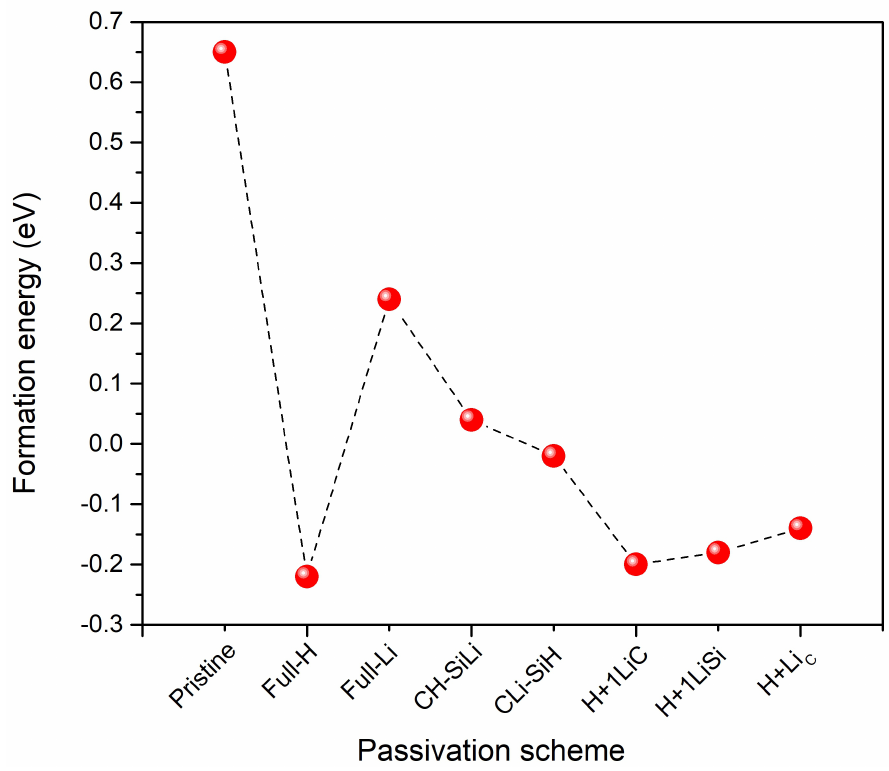
Figure 5. Formation energy of 3C-SiC(1 1 0)